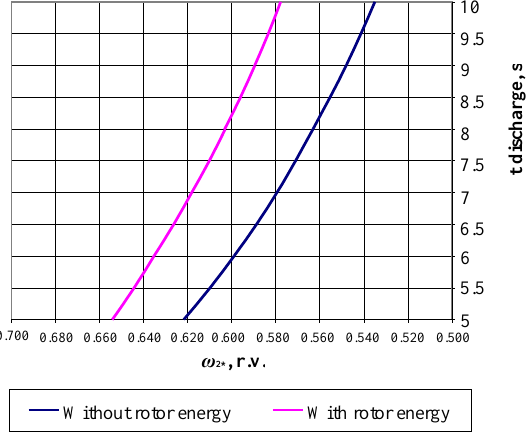
Fig. 5. m EMB  2* optimal curves with and without rotor energy with different discharge time.